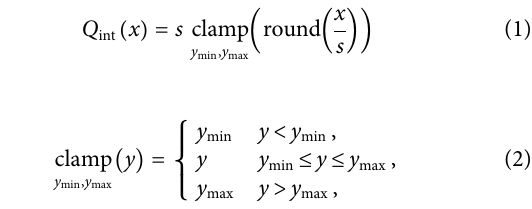
Figure 1 .The output layerhas fi ve nodes,yielding a probability foreach ofthe fi ve classesthroughasoftmaxactivationfunction.Werefertothis network as the baseline fl oating-point